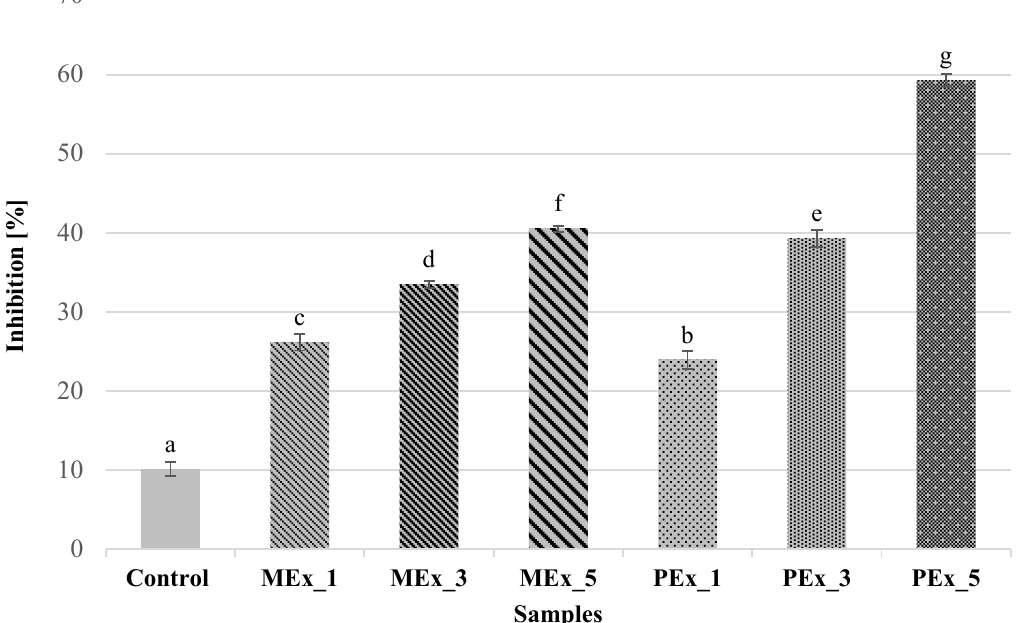
Figure 2. Mean ± SD for DPPH free radical scavenging capacity. MEx_1, MEx_3, and MEx_5—samples with 1, 3, and 5% replacement of flour on dry marigold extract, respectively. PEx_1, PEx_3, and PEx_5—samples with 1, 3, and 5% replacement of flour on dry perilla extract, respectively. a, b, c, d, e, f, g —means with different letters are significantly different (test LSD: p ≤ 0.05).